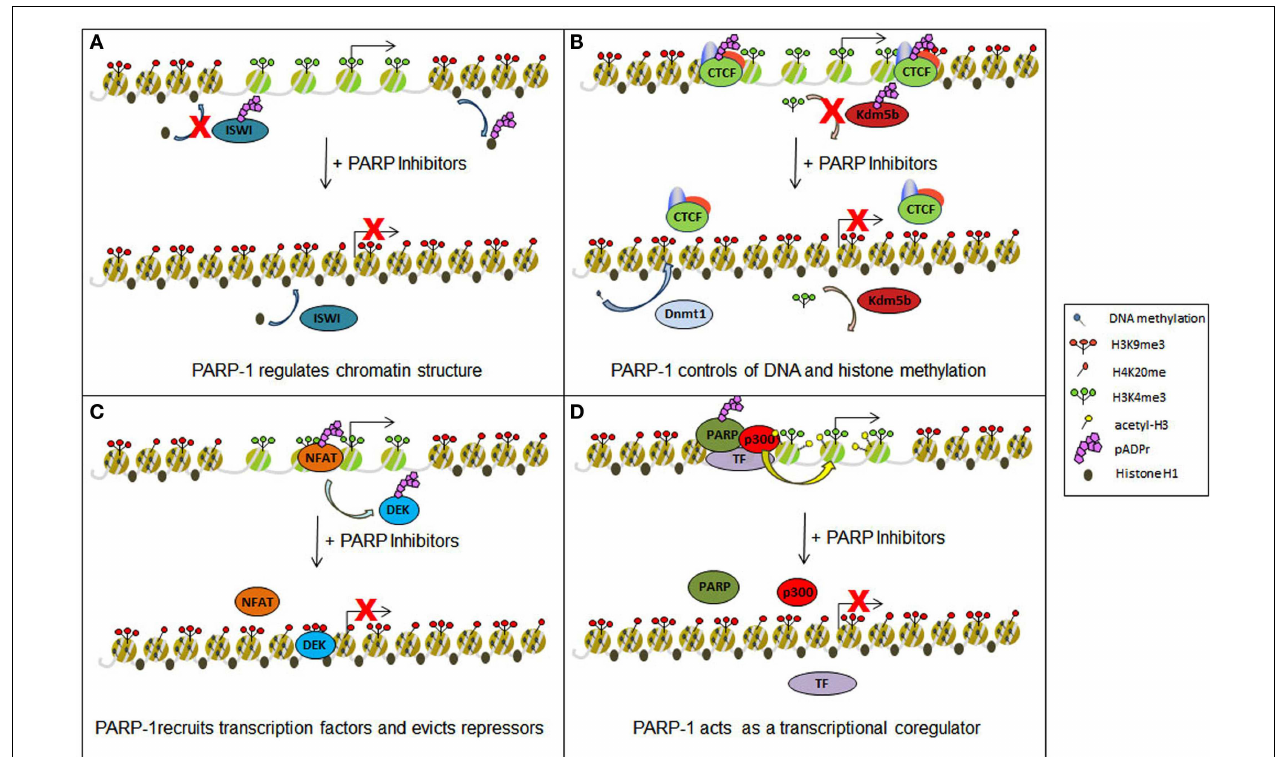
Parp inhibitors. In both incidencies, transcriptional inhibition will ensue. Such drugs may also act to restore Dnmt1 methylation of DNA, further promoting gene silencing. (C) Parp inhibition can disrupt protein: DNA interactions, preventing the maintenance of certain trans-activating factors (e.g., Nfat) at transcription start sites while also causing the retention of some repressor proteins (e.g., Dek). (D) Gene activation may also be negatively regulated by preventing Parp from acting as a transcriptional coregulator and obstructing the recruitment of such proteins as the histone acetyl transferase